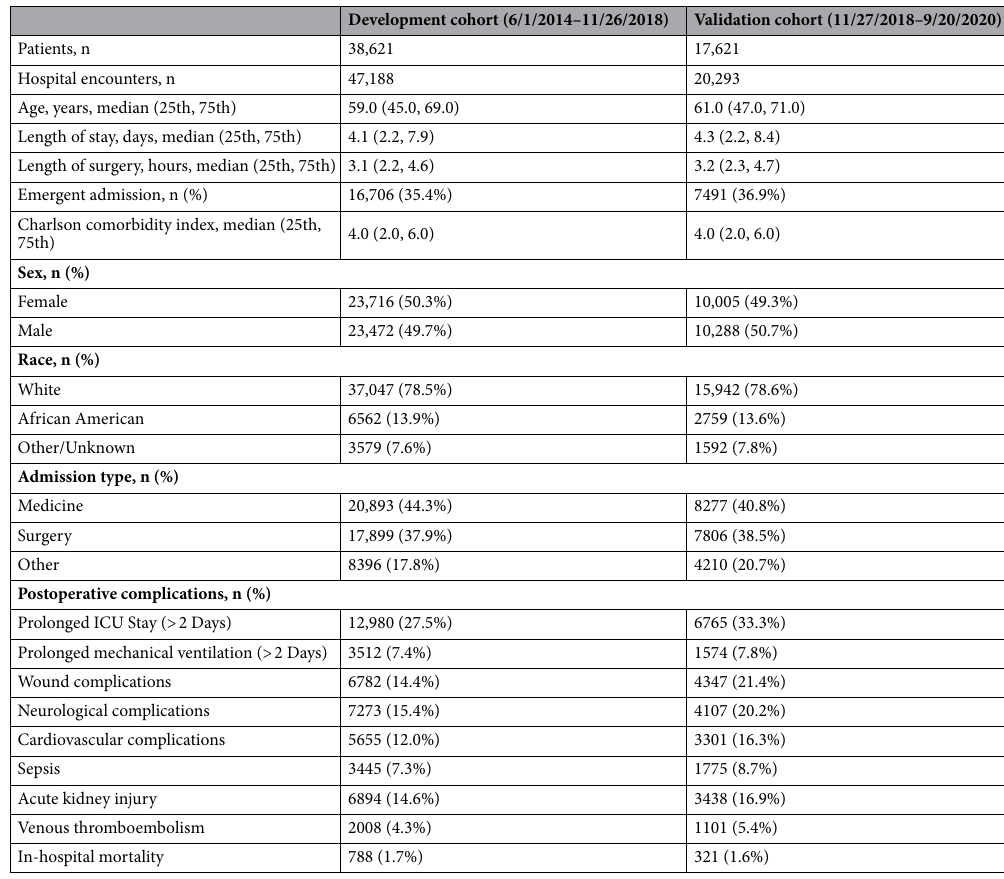
Table 1. Summary of development and validation